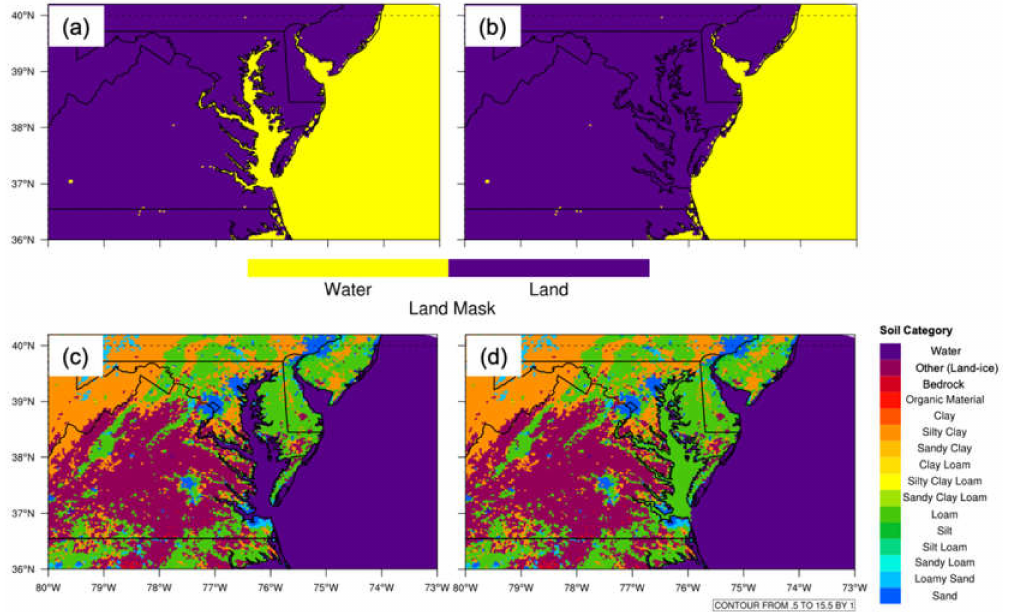
Figure 4. ( a ) WRF USGS land mask. ( b ) Same as ( a ), but modified water to land over CB. ( c ) WRF USGS 16 soil categories. ( d ) Same as ( c ), but modified water to loam over